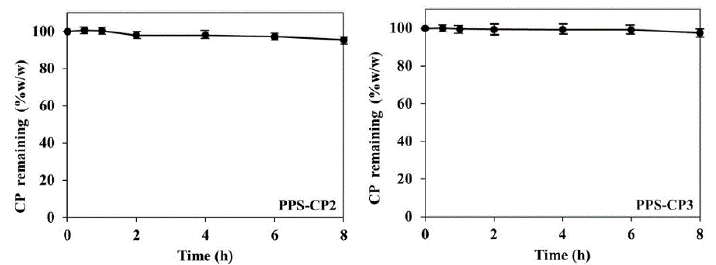
Figure 1. Stability profiles of carbamide peroxide (CP) in various EFASs at 25 °C.